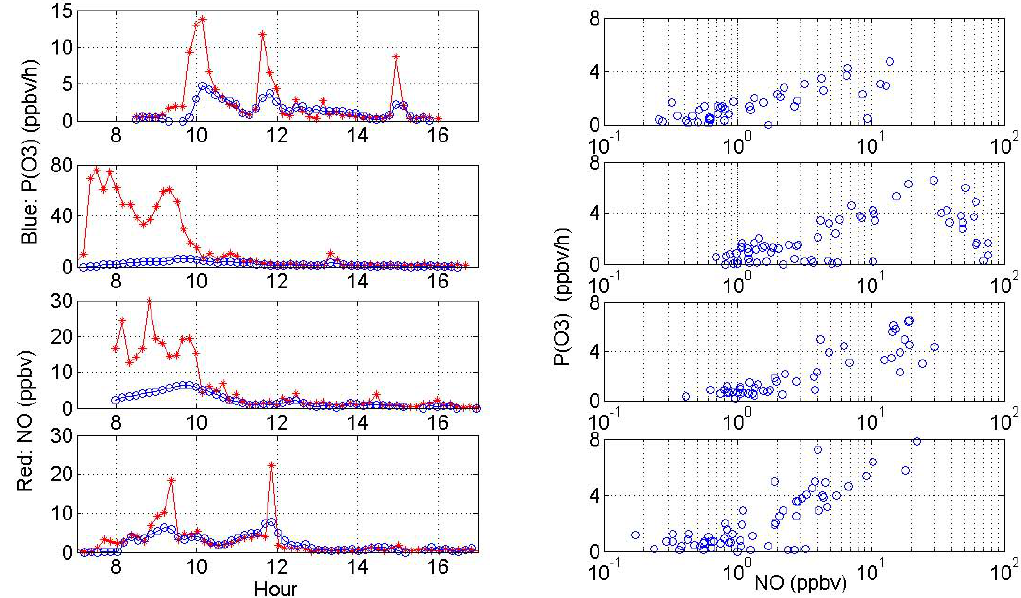
Fig. 4. Rates of ozone production measured on the campus of the Pennsylvania State University during 1 to 4 September 2008. The left column contains time series for P (O 3 ) (blue circles) and NO (red stars) for every day starting on Sep 1 and ending on 4 September 2008. The right column is the correlation between measured P (O 3 ) and ambient